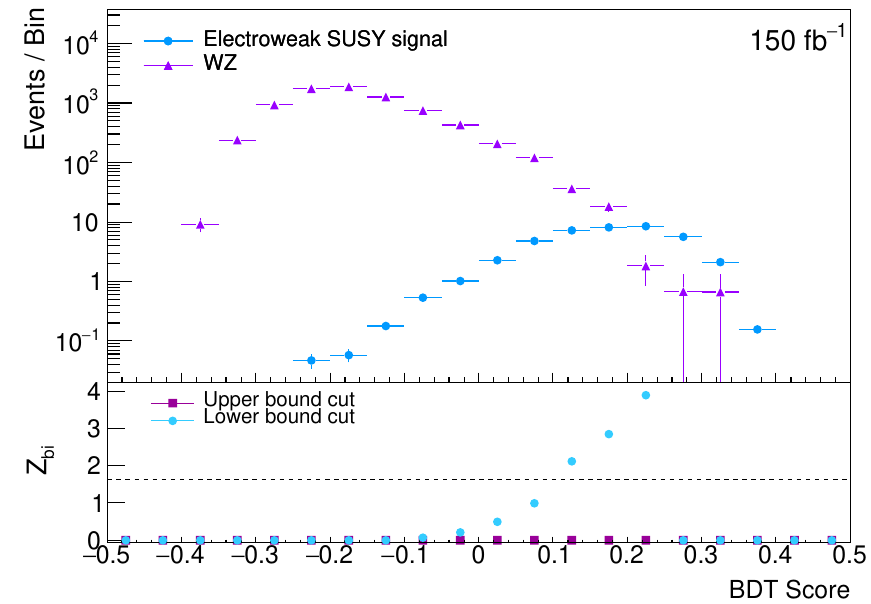
Figure 12. Distributions of the BDT score for electroweakino signal and WZ background events, in the case where k ∗ , euc is added to the BDT. In the lower panel the Z bi is also shown for cumulative ν upper or lower bound cuts on the score. Events in the overflow bin are not shown in the distribution but are included in the Z bi calculation. Note that we deliberately set Z bi to zero in the lower figure when the number of signal or background events falls below three (before